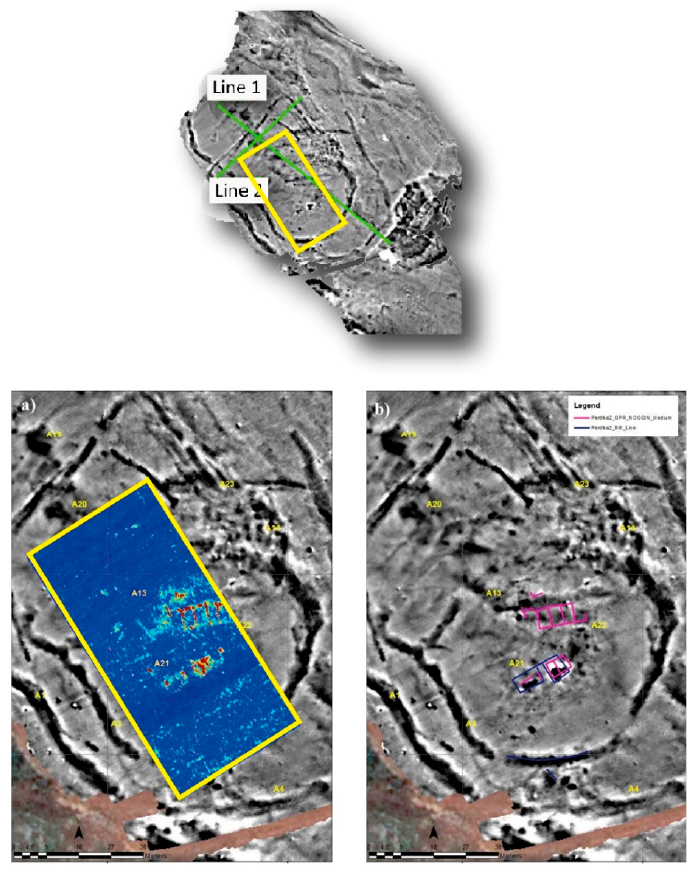
Figure 11. Georeferenced GPR time slice at 0.7, 0.8 m depth ( a ) and related annotations of the reflec- tions of interest in pink and high-resistance anomalies in dark blue ( b ) overlying the magnetometer survey data (modified from [39]). The text in yellow indicates the different features identified in the geophysical data (e.g., A1, A2 and A4 refer to the enclosures and A21-A22 notes the structures). The inset at the top shows the related magnetometer results and grid location. The grayscale range is the same as that plotted in Figures 1 and 2.